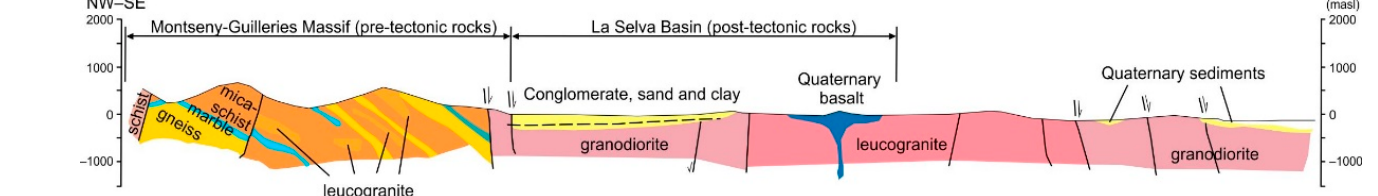
Figure 2. Hydrogeological cross-section of Montseny-Guilleries Massif–La Selva Basin. The dashed line shows the position of the water table. Modified from [24].